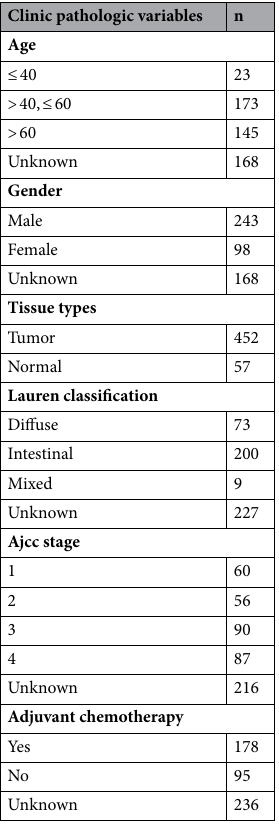
Table 1. Basic clinical data of patients included in the